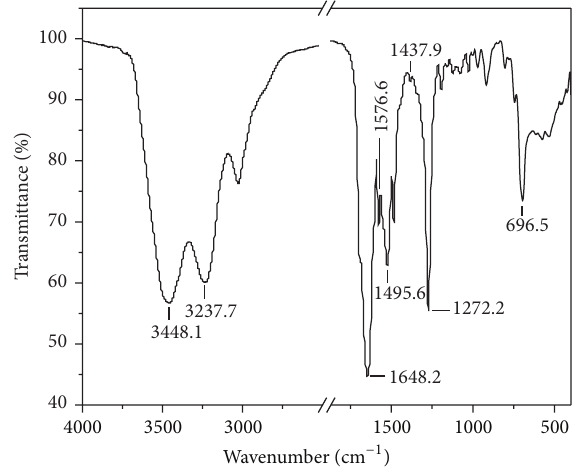
Figure 1: FT-IR spectrum of TTAD.